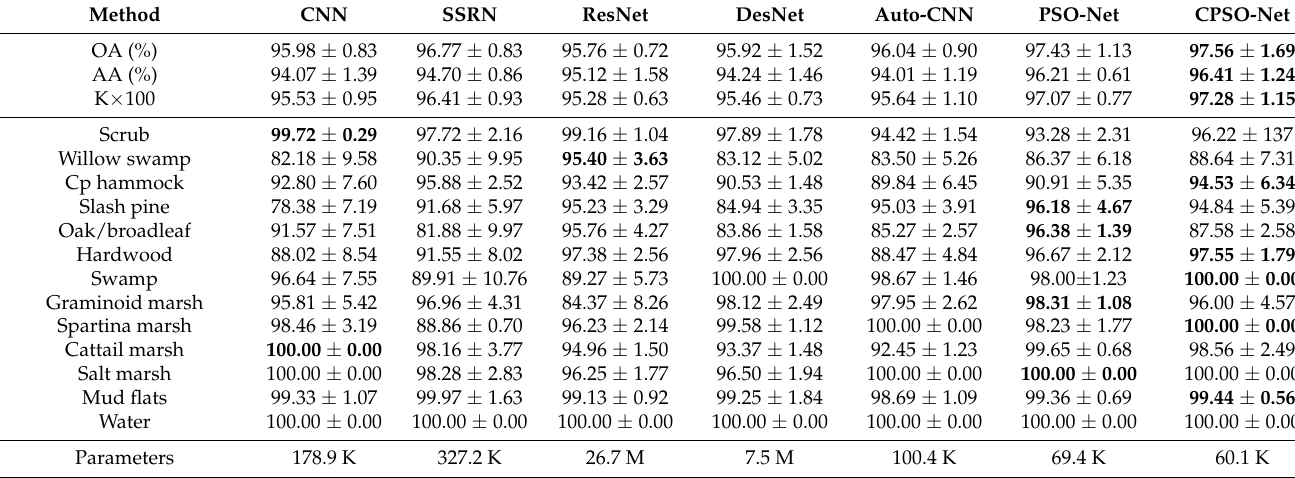
Table 6. Classification accuracy with bolding the best accuracy based on the biased KSC dataset, fun five times.